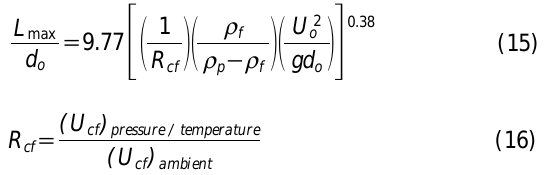
ution of solids and gases in a riser [32-34], and the flow characteristics of downflowing high-velocity flu- idized beds [35,36].